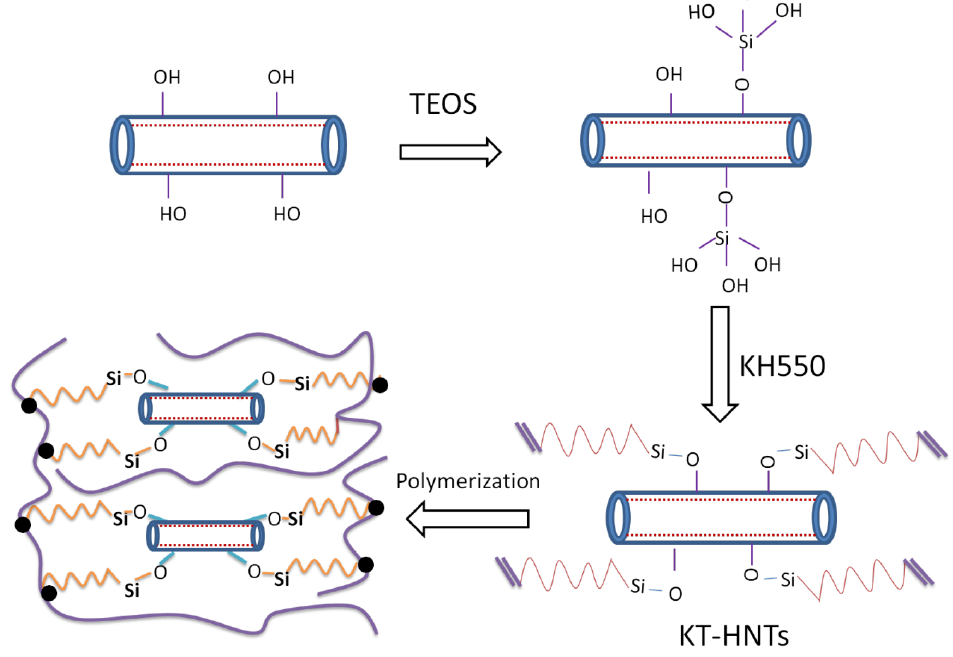
Figure 11. The formation mechanism of PMMA/reactive halloysite nanocomposite.